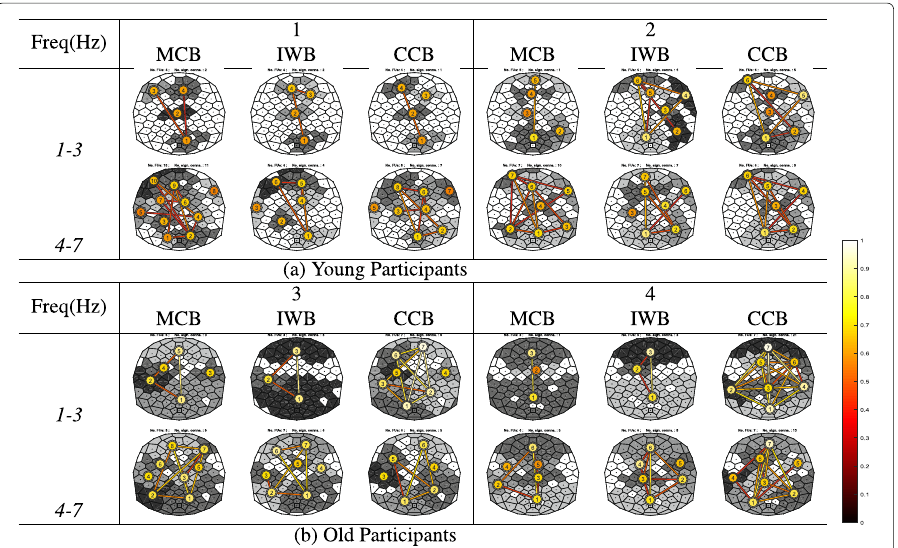
Fig. 8 Illustration of FU maps (top view, nose on top) obtained by using the three FU detection methods for two different EEG frequency bands. a FU maps obtained from two young participants. b FU maps obtained from two older